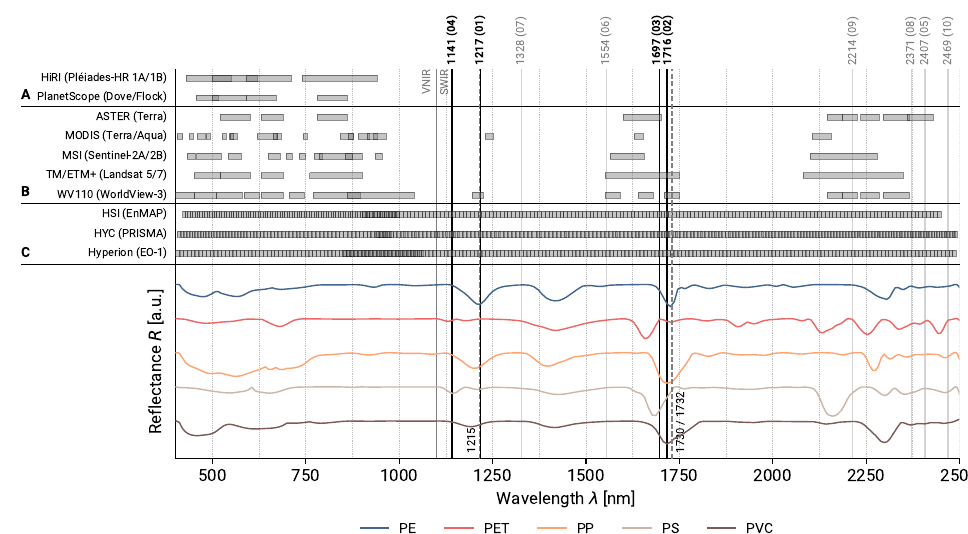
Figure 9. Output of sequential forward selection in SWIR using continuum removed spectra classified with k-NN. Black vertical lines show the positions of the selected features, with their ranking given in parentheses. The first four features alone resulted in best classification performances. Dashed vertical lines show positions of hydrocarbon features at 1730nm [21] and plastic features at 1215 and 1732nm [29]. Additionally, mean continuum-removed reflectance spectrum per plastic type and the channel wavelength ranges of selected sensors are shown, where ( A ) are multispectral VNIR sensors, ( B ) are multispectral VNIR/SWIR sensors, and ( C ) are hyperspectral